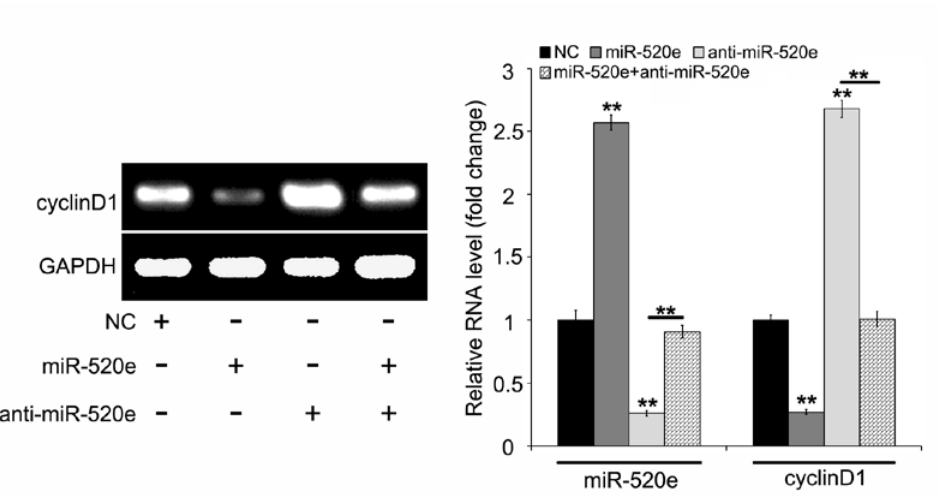
Figure 2: Anti-miR-520e reverses the inhibition of cyclinD1 induced by miR-520e. The expression of cyclinD1 at the mRNA level was tested by using RT-PCR assay of one-point detection in electrophoresis results and quantitative real-time PCR from a minimum of three different repeats for each sample. Meanwhile, the level of miR-520e in the cells transfected with miR-520e and anti-miR-520e was evaluated by quan- titative real-time PCR when MCF-7 cells were treated with negative control mimics, miR-520e and/or anti-miR-520e. Statistical quantification from at least three independent experiments is included. *P <0.05; **P < 0.01; ***P < 0.001; Student’s t